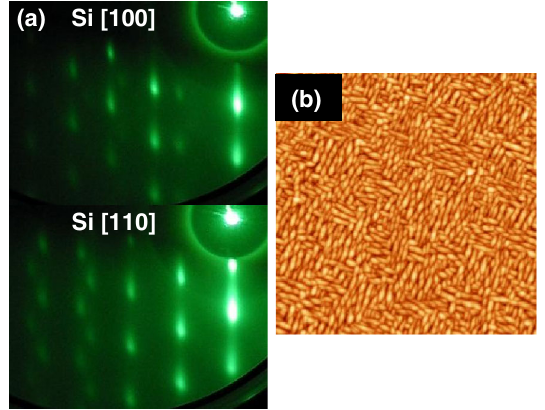
FIG. 6. Critical temperature transitions for films deposited at RT and 150 (cid:2) C .